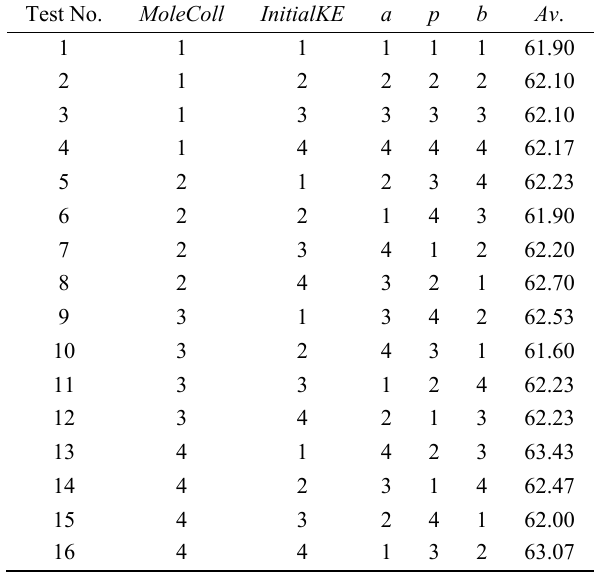
Table 6 Average values for different combinations of parameters.